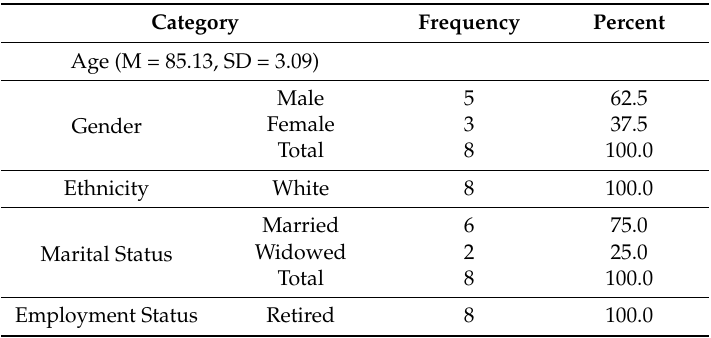
Table 1. Characteristics of participants (n =